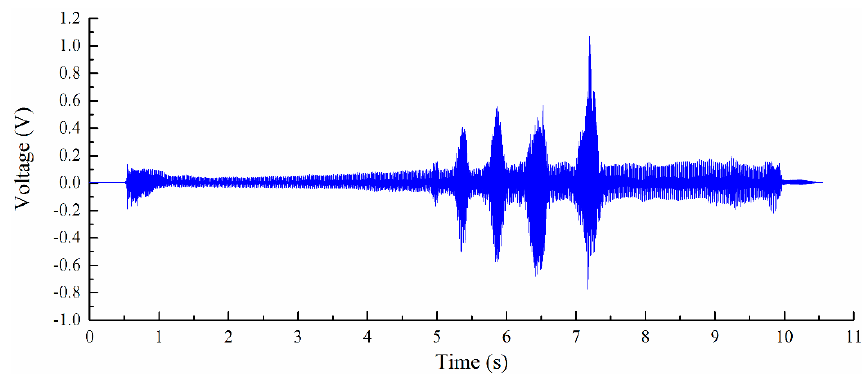
Figure 6. Output signals of the real-time monitoring system.